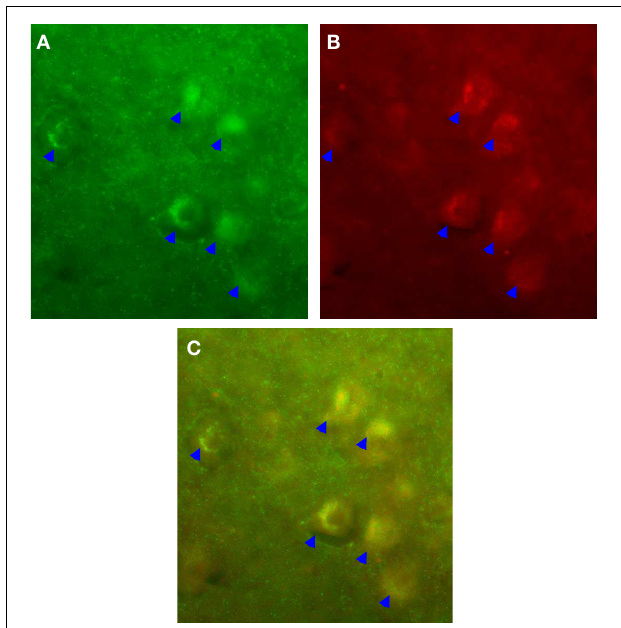
FIGURE 10 | IHC showed expression and co-localization of GAD 67 and BDNF in the ventral horn (VH) motoneurons (arrows). GAD 67 showed a diffuse staining in cell bodies and fibers as well as punctate staining in theVH (A) . Interestingly, those GAD 67 immunostained motoneuron cell bodies also stained with BDNF (B) ; (C) is the merged image of (A,B) (20 ×